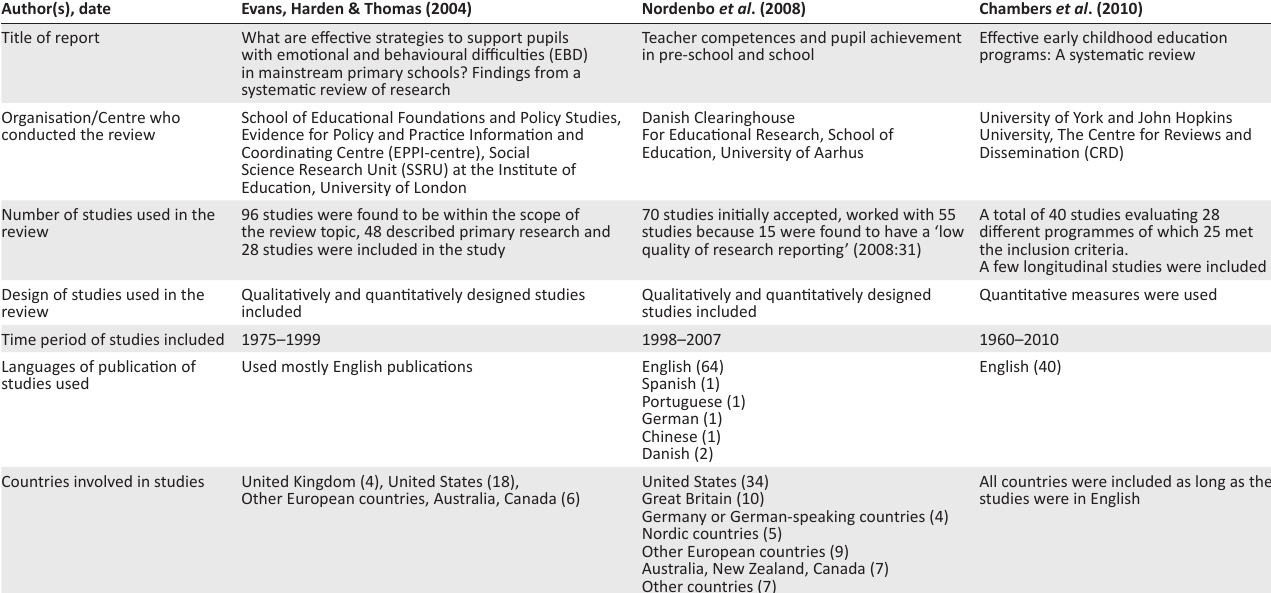
TABLE 1: Summary of three systematic reviews.